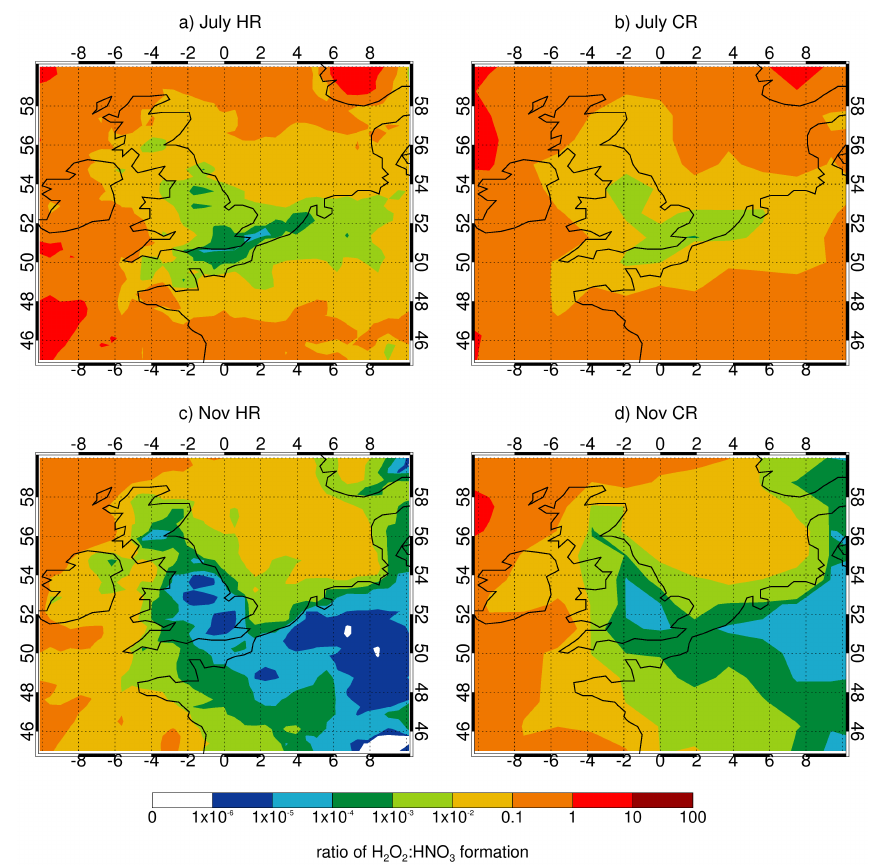
Fig. 6. Monthly mean surface chemical regime as indicated by the ratio of H 2 O 2 : HNO 3 formation. Blue colours indicate a more VOC-limited environment and red colours indicate a more NO x -limited environment.